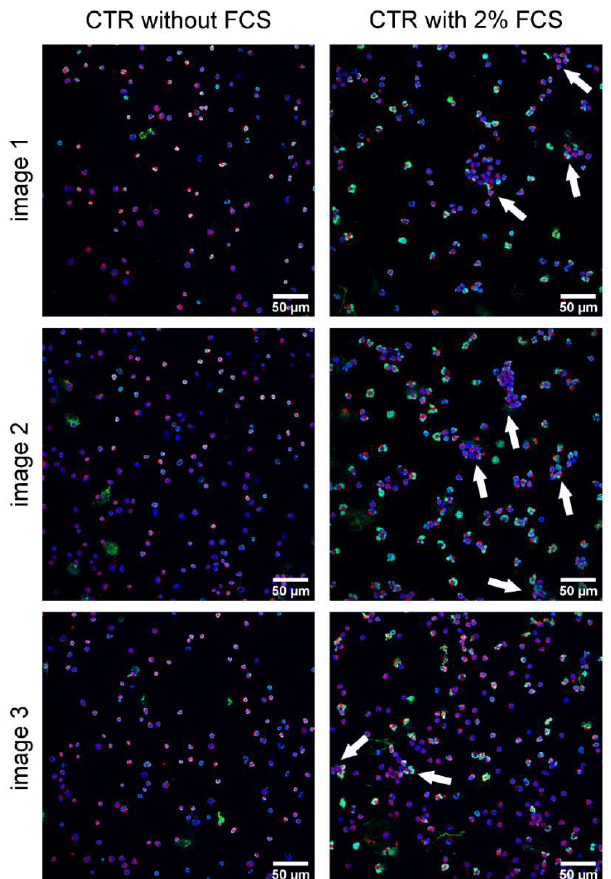
Figure A2. Representative immunofluorescence images (overlay) of NET induction assays with and without 2% FCS are presented. RPMI was used as unstimulated control (CTR). Staining: Blue = DNA; green = DNA/histone-1-complexes; red = myeloperoxidase. White arrows mark clumping neutrophils. All settings were adjusted to respective isotype controls.